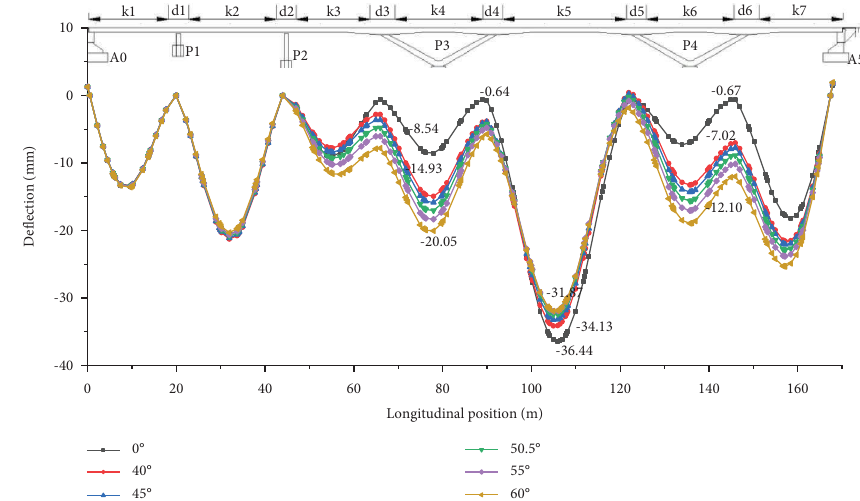
Figure 11: Te girder’s defection for diferent V-shaped pier’s angles.